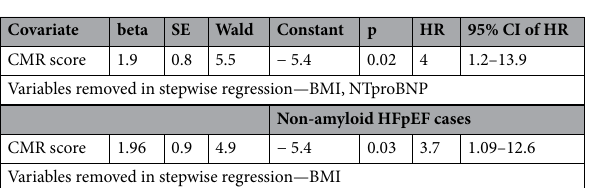
Table 6. Stepwise multivariate regression in all cohort and the non-amyloid cohort. For the whole HFpEF cohort, variables included for analysis were CMR score, BMI and NTproBNP. For the non-amyloid HFpEF cases, variables included for analysis were CMR score and BMI